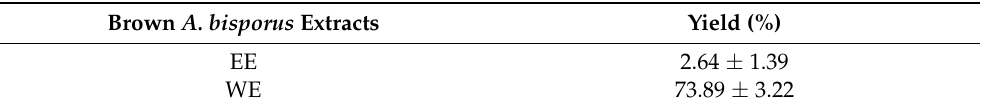
Table 1. The percentage of yields of brown A. bisporus ethanol extract (EE) and brown A. bisporus water extract (WE).